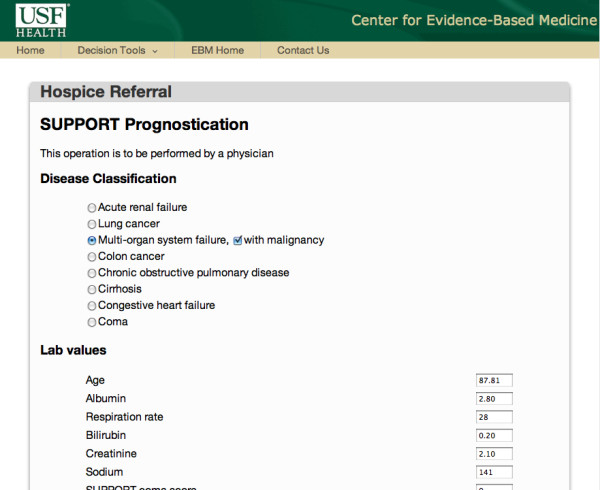
SUPPORT user interface. The user enters all information regarding the particular patient to compute the probability of death and survival within the next 6 months. LE results are presented to the patient through the decision justification module after the patient's request.